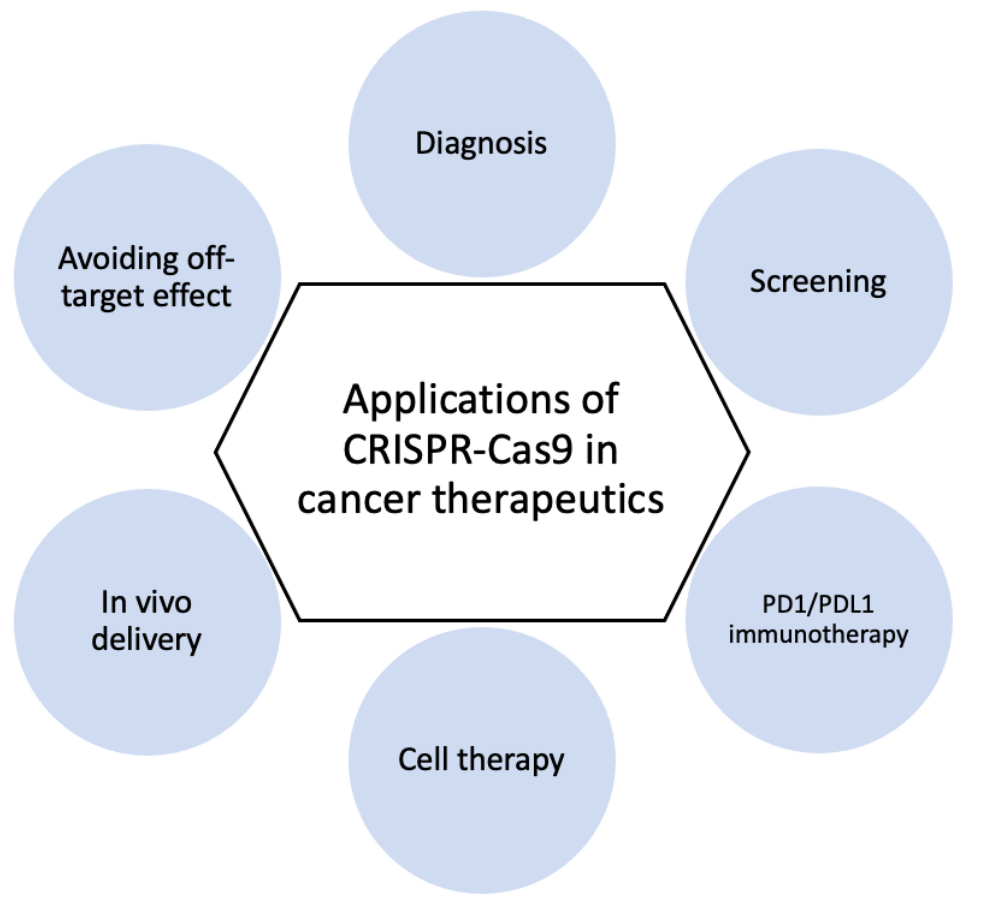
Figure 2. Applications of CRISPR-Cas9 in cancer